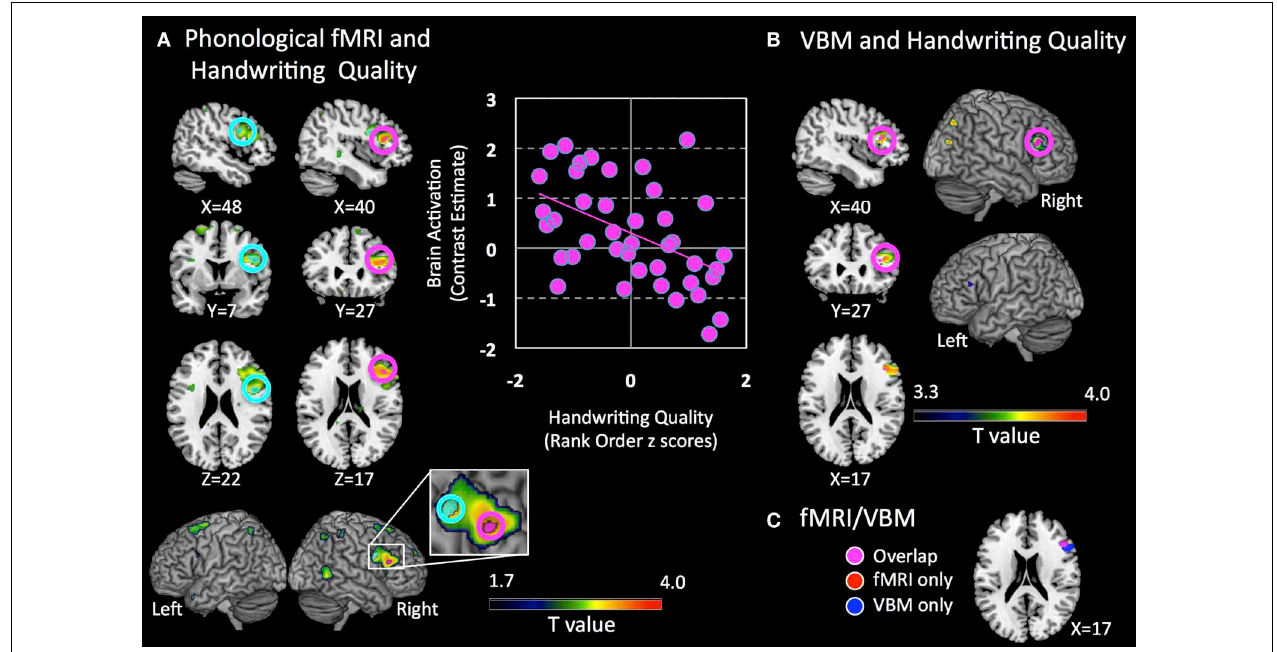
FIGURE 3 | Brain regions associated with handwriting quality. (A) Clusters that show negative association with brain activation during a phonological processing fMRI task are shown. Pink circles indicate a cluster that is significant at p = 0 . 05 corrected (right inferior frontal gyrus pars triangularis, IFGtri), and cyan circles indicate a cluster that shows a trend p = 0 . 054 corrected (right Exner’s area). Clusters indicate voxels significant at a lenient threshold of p = 0 . 05 uncorrected to show greater extent of activation. XYZ coordinates are in Talairach coordinates. Panel on the right shows a scatter plot representation of the cluster that shows significant negative association at p = 0 . 05 corrected (pink cluster). Brain activation is